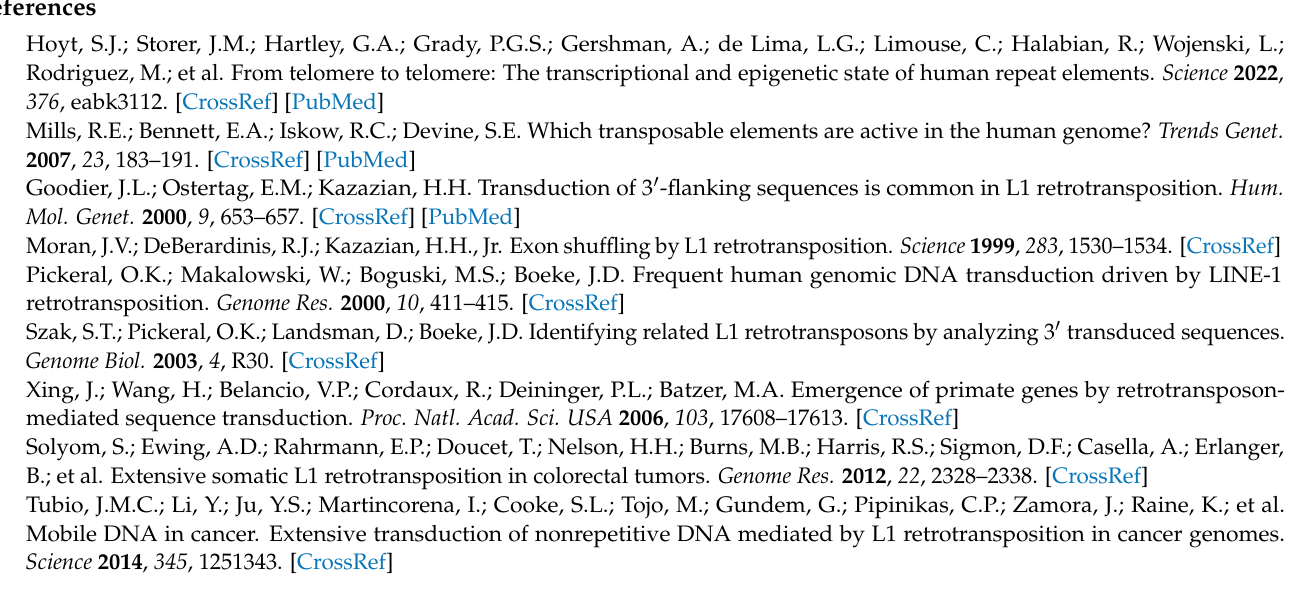
Table S4: source elements of L1 and SVA transductions with their transduced length; VCF